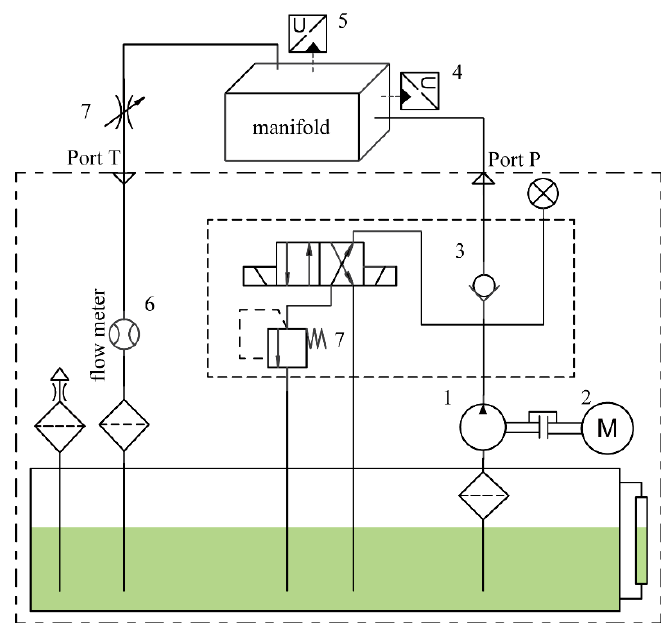
Figure 4. Schema of the test rig: 1—hydraulic pump; 2—motor; 3—check valve; 4,5—pressure transducer; 6—flow meter; 7—throttle valve. Table 1. Characteristics of measuring device.